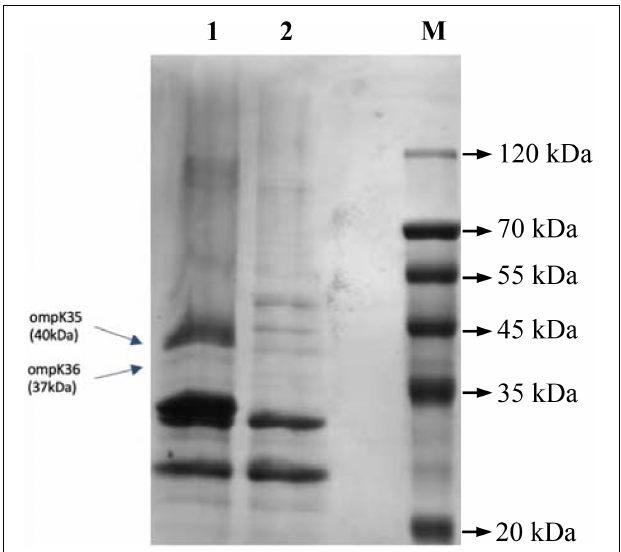
FIGURE 2 | OMP analysis by SDS-PAGE. 1, K. pneumoniae ATCC35657; 2, K. pneumoniae L204; M,